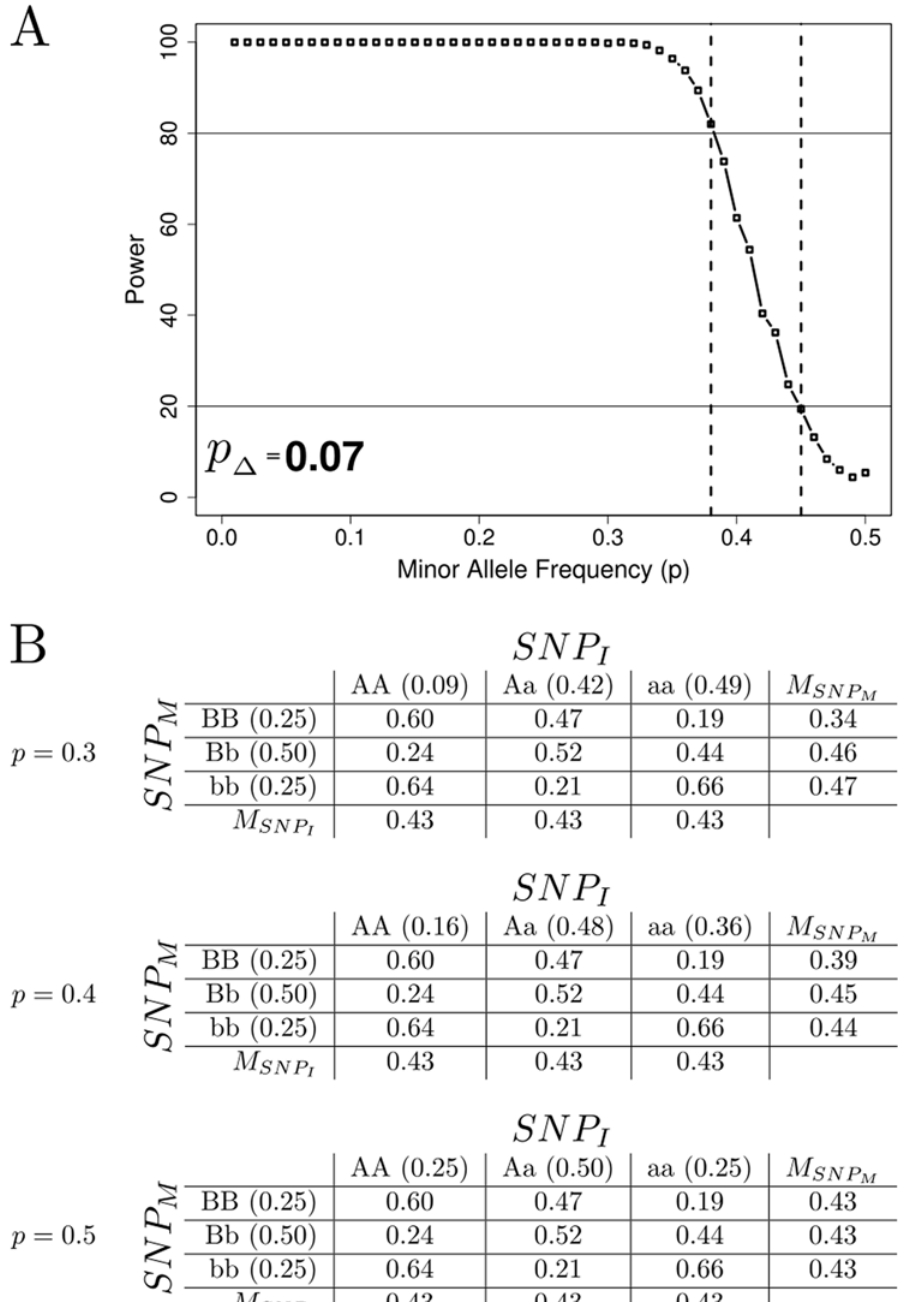
Figure 1. A. This is an example of power results and marginal penetrance tables for an epistatic model with a heritability of 0.1. Part A shows power results. As the minor allele frequency approaches the epistatic minor allele frequency, the power to detect the main effect in a replication sample is reduced. A change of 0.07 in minor allele frequency ( p D ~ 0 : 07 ) is enough to drop the power to replicate SNP M from 80% to 20% for this model. It is apparent in B that as the minor allele frequency, p , of SNP I in the sampled population moves from 0.3 to 0.5 the marginal ) become equal and the main effect is lost. When the replication sample is performed at an allele penetrances of the alleles for SNP M ( M SNP M frequency of 0.3 the power to detect a main effect is near 100%, at an allele frequency of 0.4 the power to detect a main effect is near 60%, and at an allele frequency of 0.5 the marginal penetrances are equivalent and no main effect remains.